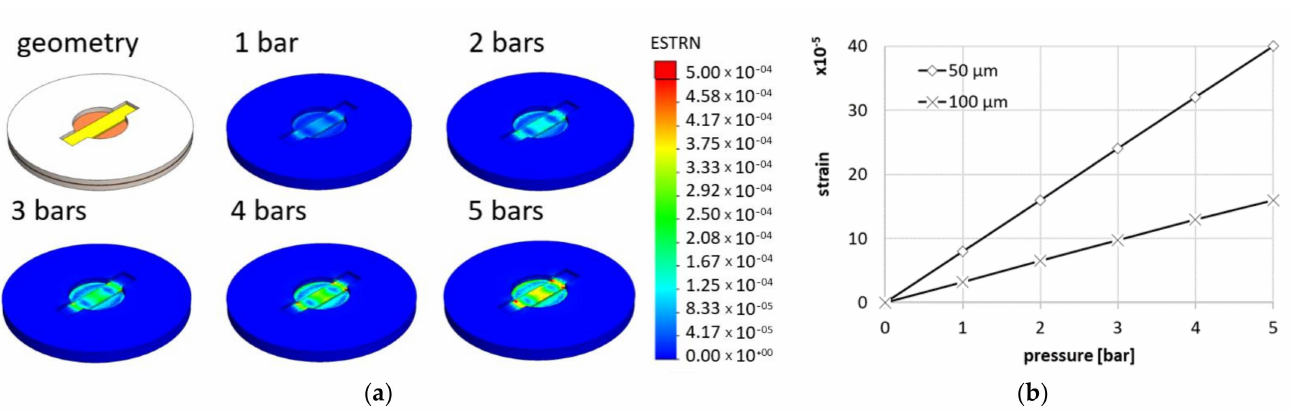
Figure 12. SIMS depth profiles for the studied samples: 6H-SiC-3%N ( a ), 4H-SiC-3%N ( b ), 6H-SiC-3gB ( c ) and 6H-SiC-N-Sc ( d ).